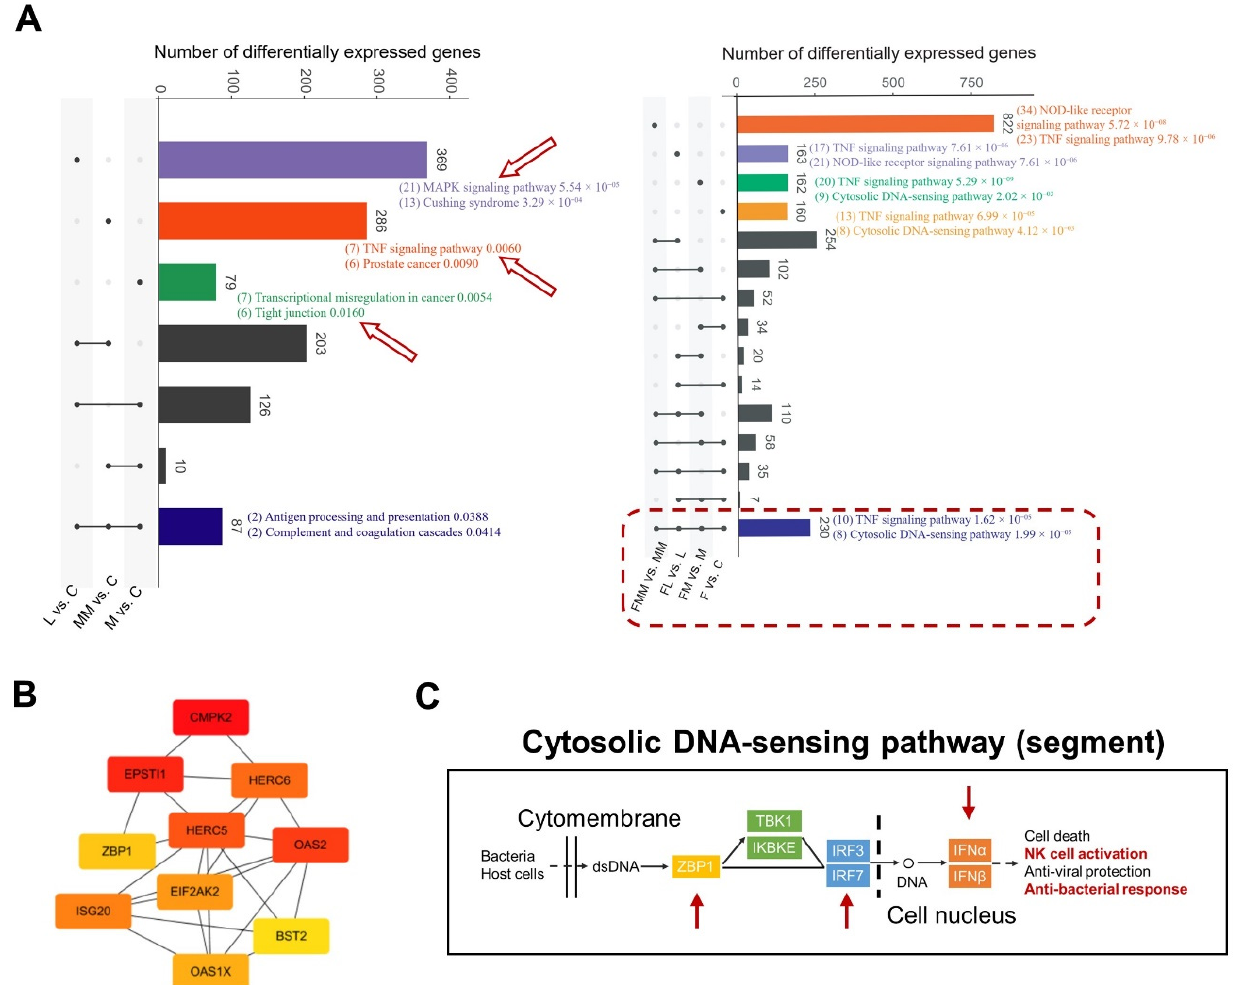
Figure 4. Cytosolic DNA-sensing pathway can be regarded as a key pathway for improving host anti- S. aureus and MRSA damage. ( A ) Enriched KEGG pathways and corresponding p values in common and unique differentially expressed genes among different comparison sets. ( B ) Top 10 hub genes of 230 common differentially expressed genes between FA treatment groups and corresponding controls. ( C ) Part of the genes involved in cytosolic DNA-sensing pathway, and DEGs in this pathway were marked by the red arrow.